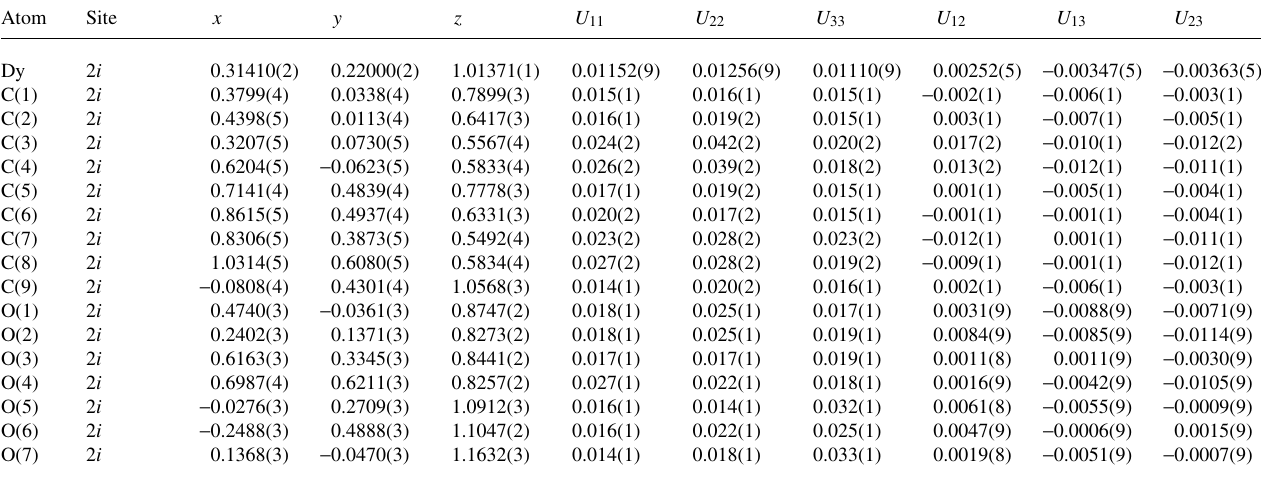
Table 3. Atomic coordinates and displacement parameters (in Å 2 )